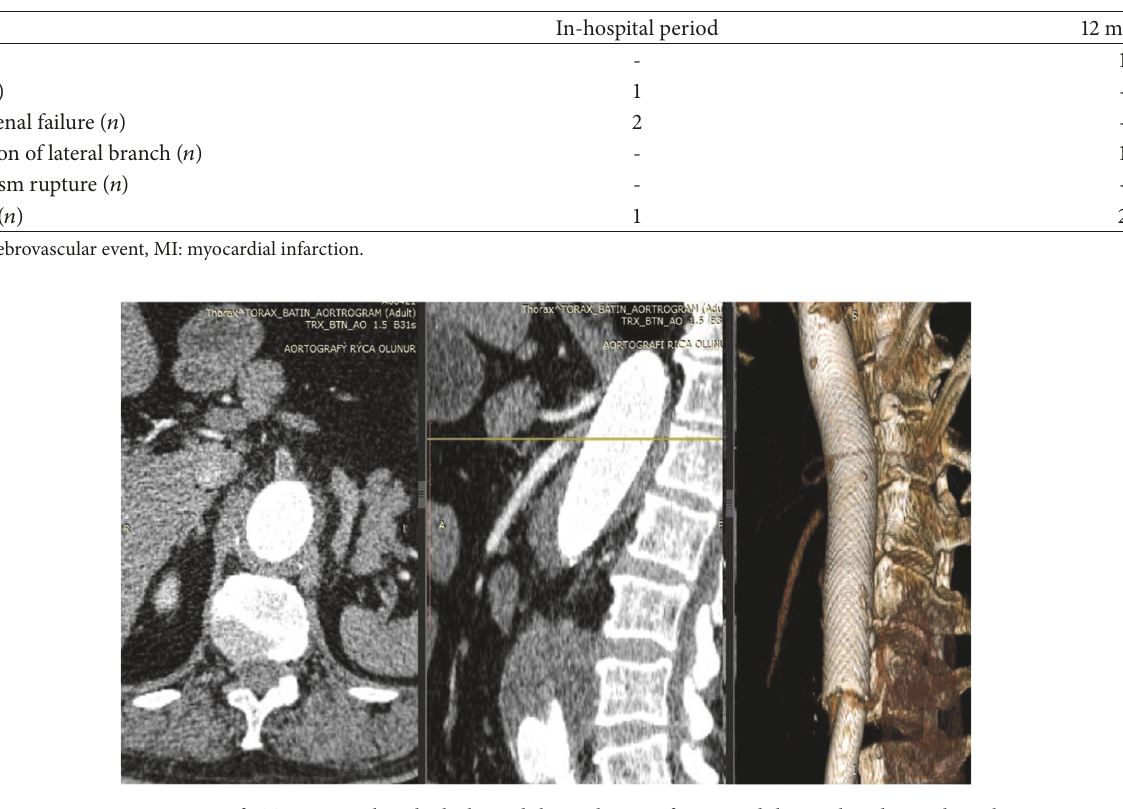
Figure 3: Images of CT angiography which showed the occlusion of SMA and the Coeliac due to